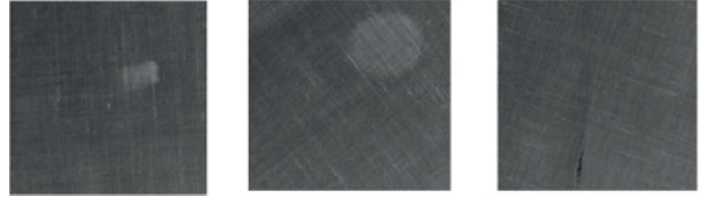
Fig. 6 Typical missed patterns under the colour histogram algorithm.